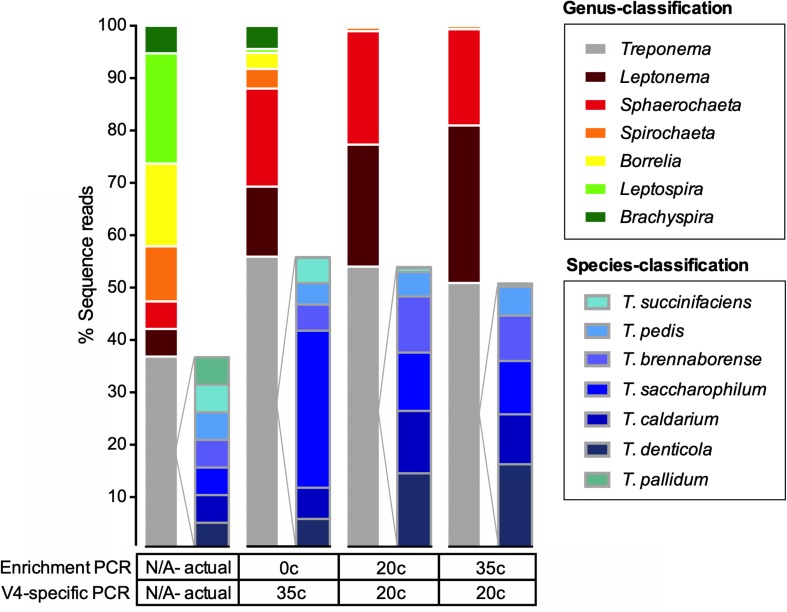
Actual and observed proportions of a spirochete mock community to a genus and species-level. Relative abundance of OTUs in percentage of reads for a spirochete microbial mock community amplified using multiple methods. The spirochete enrichment and V4-region-specific PCR cycle numbers are shown below the taxa plots. The expected strain proportion (actual) of the spirochete mock community represents the theoretical composition and was corrected for differential copy number of the 16S rRNA gene. Species-level classification only shown for the genus Treponema.